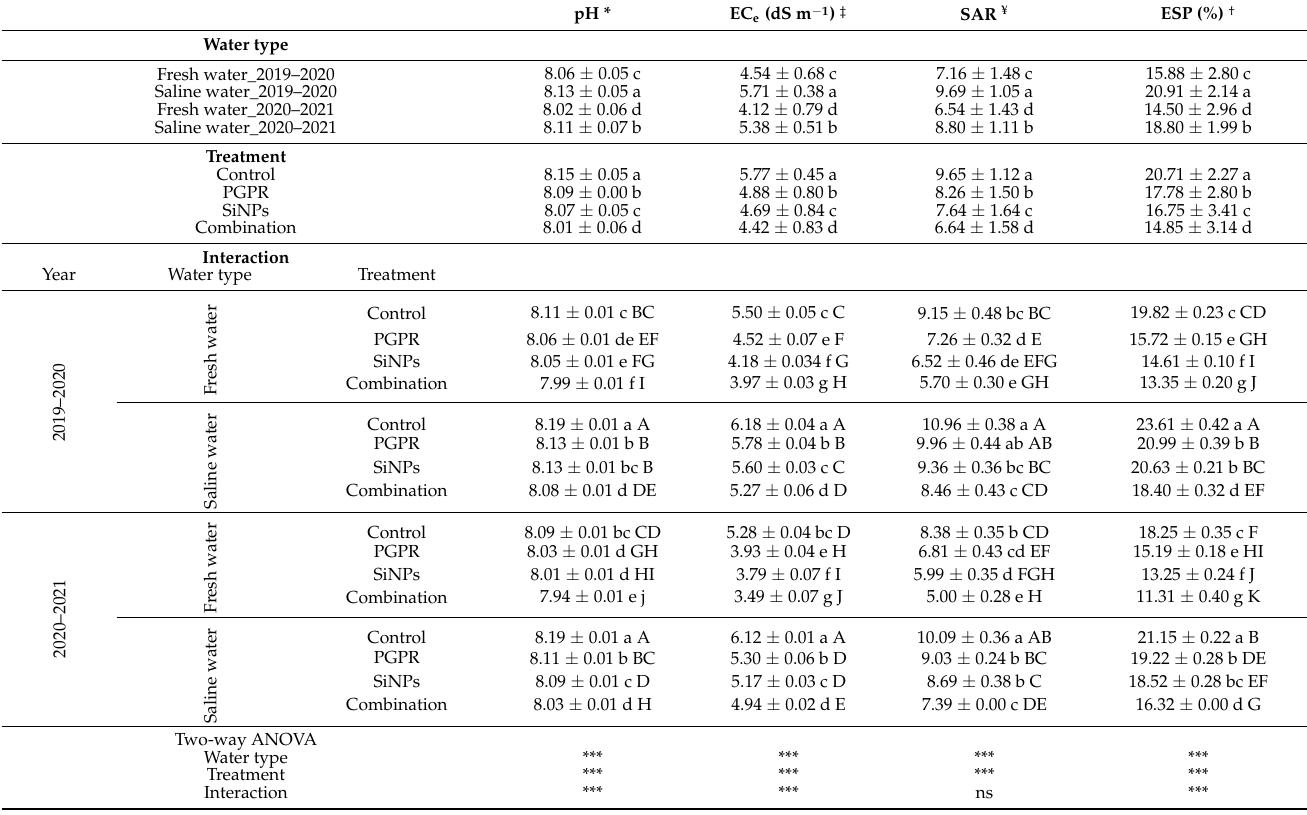
Table 1. Alteration of some chemical properties of salt-affected soil cultivated with barley ( Hordum vulgare L., cv. Giza 132), which was treated with plant growth-promoting rhizobacteria (PGPR; Azotobacter chroococcum SARS 10 and Pseudomonas koreensis MG209738), silica nanoparticles (SiNPs), and their combination to alleviate the detrimental impacts of saline irrigation water during two consecutive